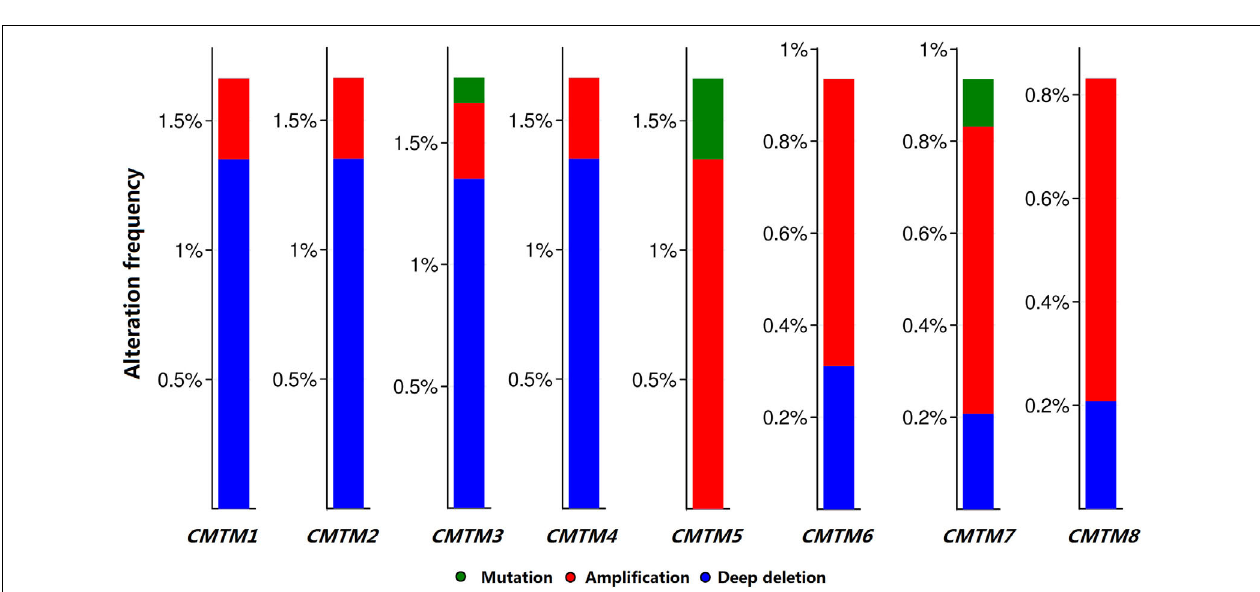
FIGURE 2 | mRNA expression levels of CMTM family members in invasive breast carcinoma samples and corresponding normal tissues from the UALCAN database ( ∗∗ P < 0.01). (A) CMTM1 , (B) CMTM2 , (C) CMTM3 , (D) CMTM4 , (E) CMTM5 , (F) CMTM6 , (G) CMTM 7, and (H) CMTM8.